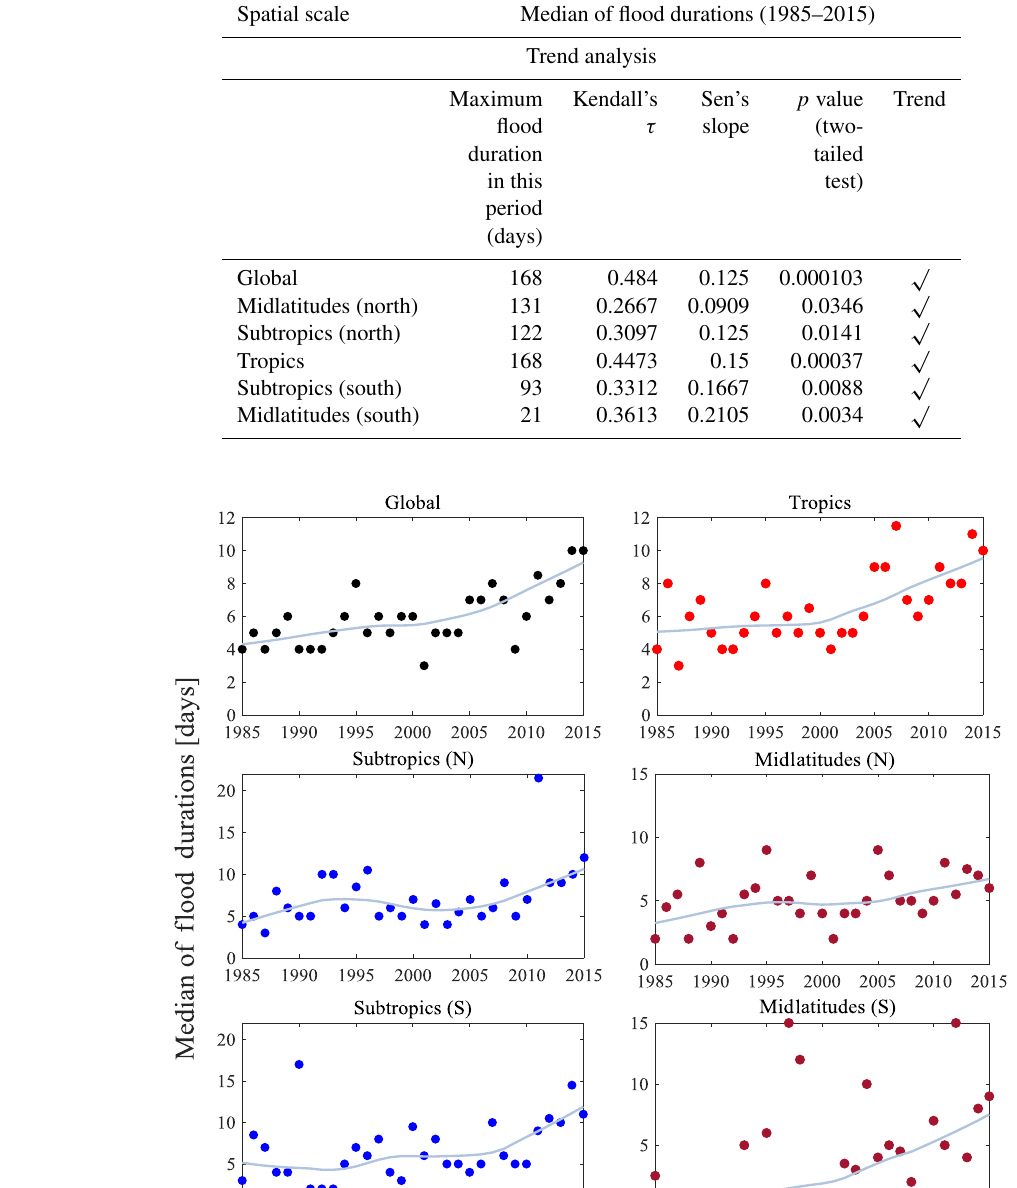
Table 3. Same as Table 2 but for the median of flood durations.